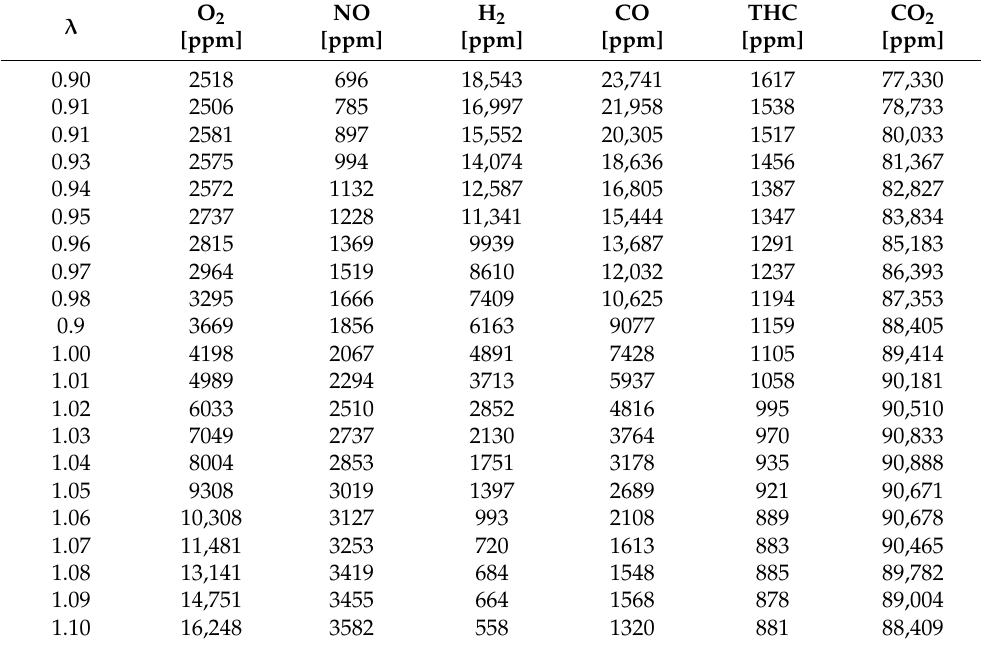
Table A1. List of Inlet Species Concentration at Different λ Values during λ -Ramp at 520 ◦